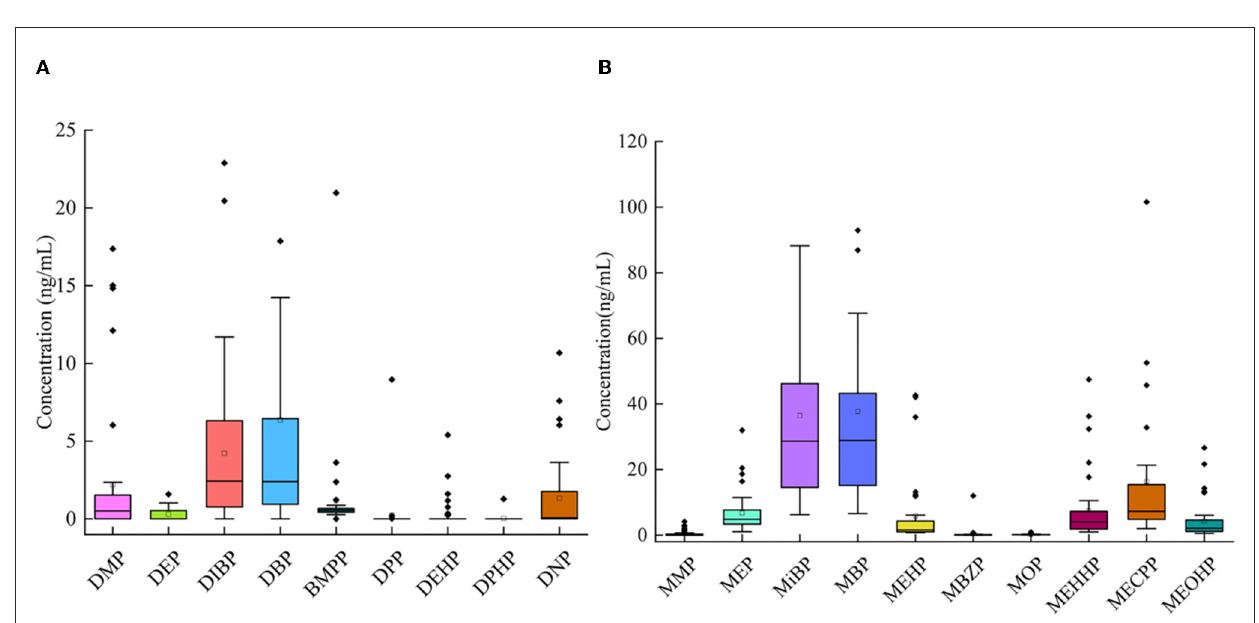
FIGURE1 Concentrations of 9 PAEs (A) and 10 mPAEs (B) in urine of all participants from Tianjin.